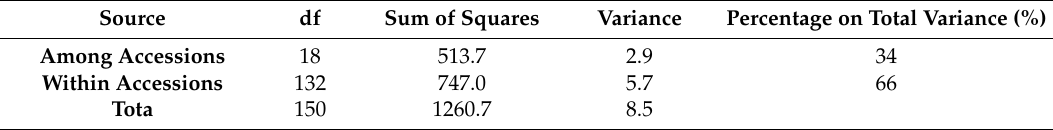
Table 2. Analysis of molecular variance among and within Apulian kale accessions.